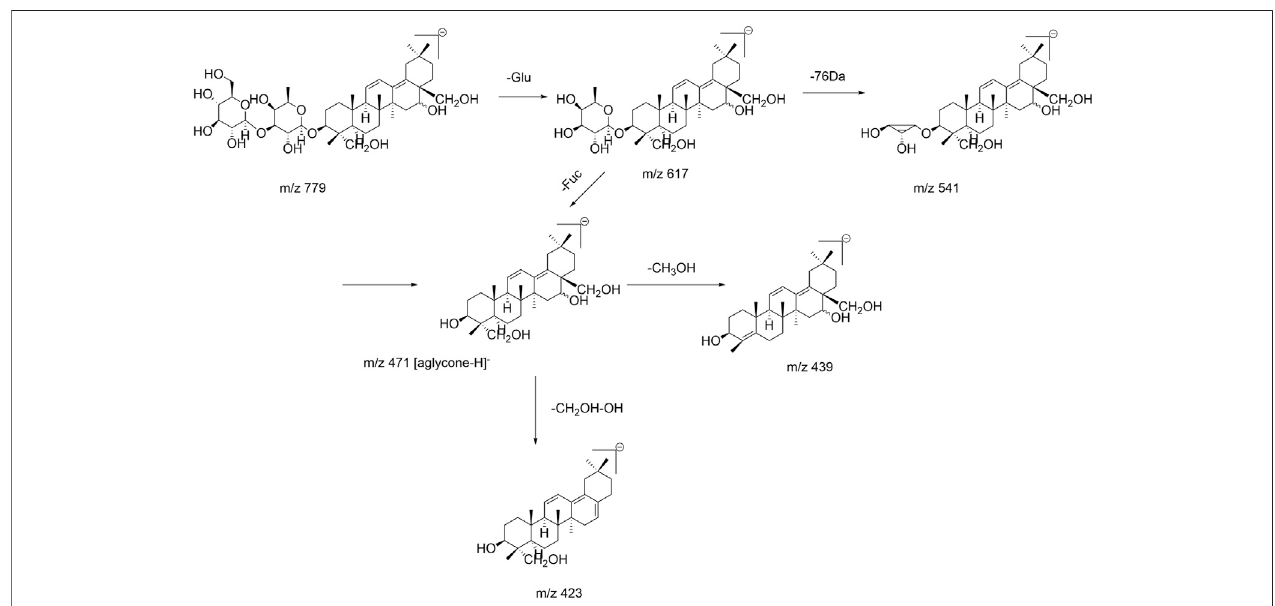
FIGURE 3 | Fragmentation pathway of SSb 1 /SSb 2